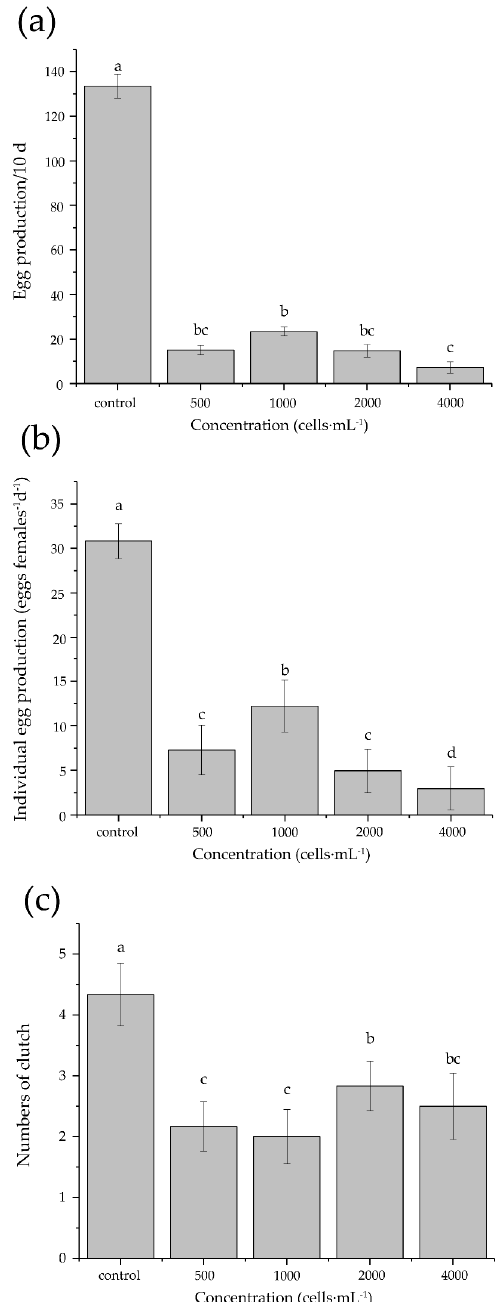
Figure 5. Fecundity ( a , b ) and number of clutch ( c ) of T. japonicus exposed to different K. mikimotoi concentrations. Different letters indicate a significant difference among treatments at p < 0.05.